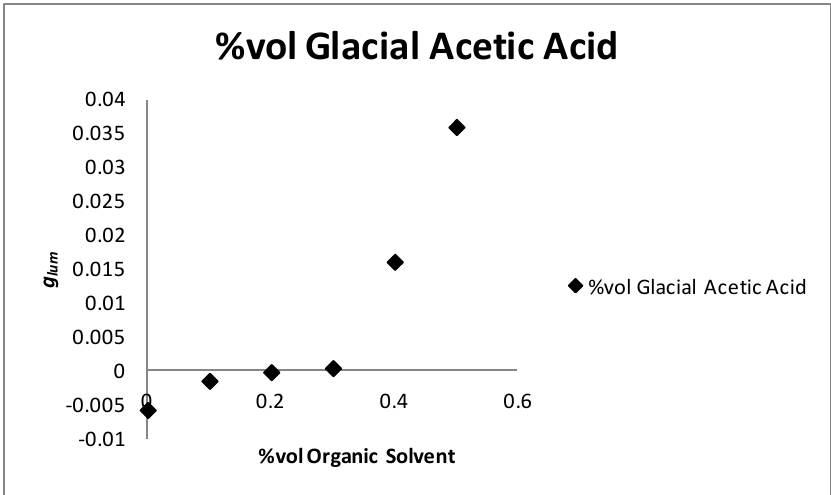
Figure 9. Plots of luminescence dissymmetry values ( g lum ) of [Tb(DPA) 3 ] 3− . Conditions: 0.005 M [Tb(DPA) 3 ] 3− with 40 equiv. L -serine. Ratios of 90:10–50:50 H 2 O:GAA (where GAA = Glacial Acetic Acid), monitored at the spectral range of 5 D 4 → 7 F 5 at room temperature and pH 7.00, and measured at λ ex = 283.00–289.00 nm and λ em = 542.80–543.00 nm.